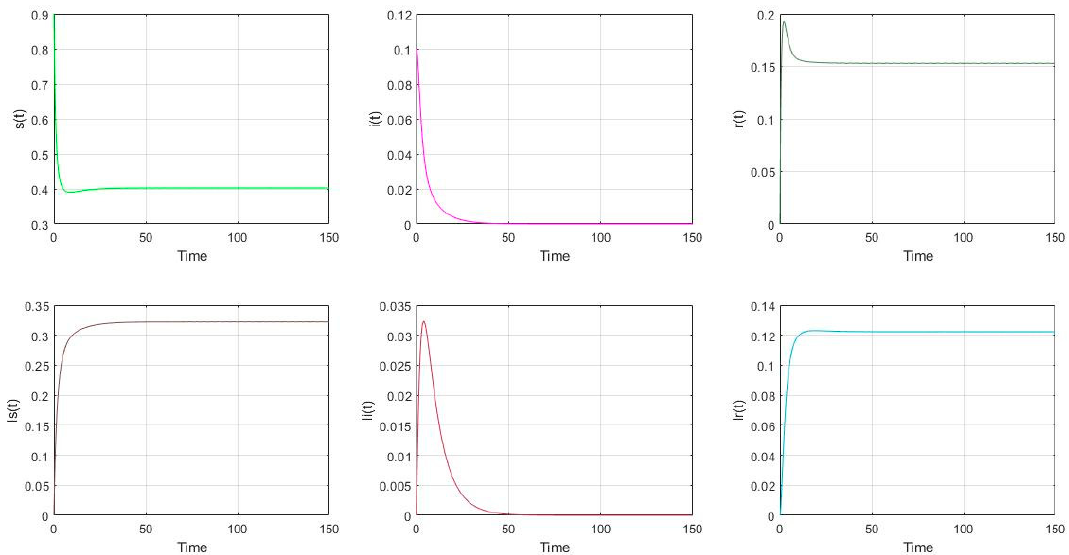
Figure 4. The distribution of nodes if R 0 = 0.5743 and β 2 = 0.2 .